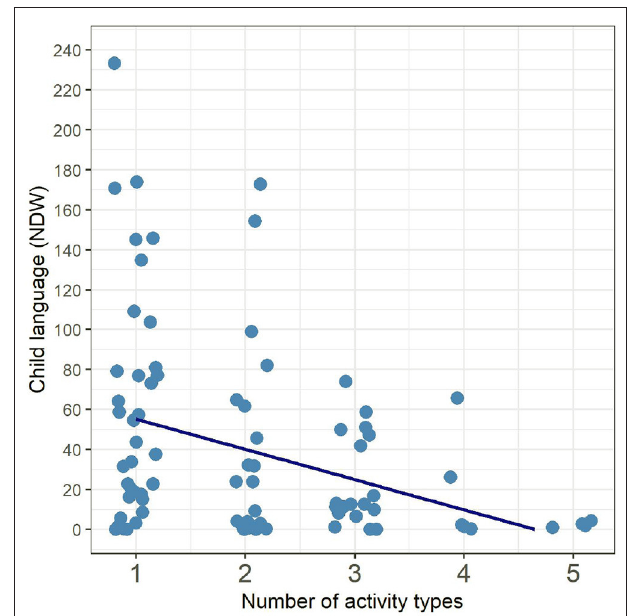
FIGURE 2 | Number of different activity types and child spoken language level.